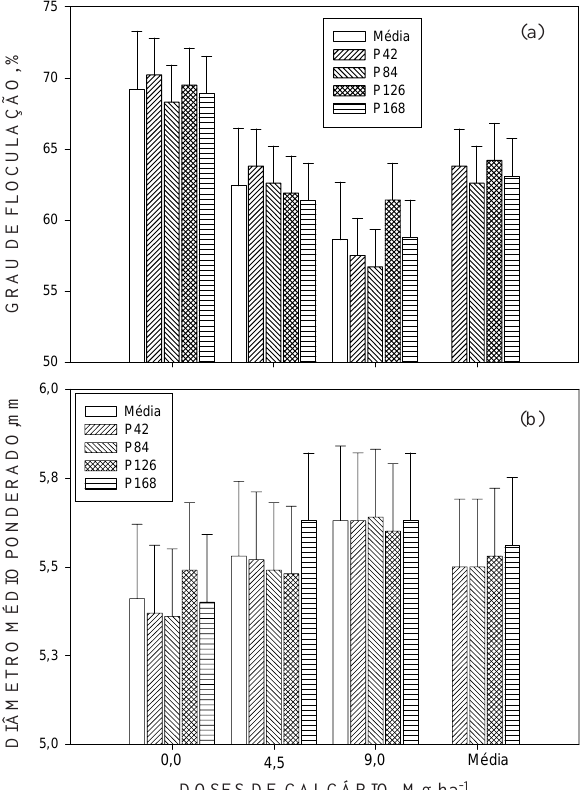
Figura 1. Efeito da calagem e adubação fosfatada sobre o grau de floculação da argila (a) e sobre o diâmetro médio ponderado dos agregados (b) de um Latossolo Bruno argiloso álico. Barras verticais entre médias do fator fósforo e entre médias do fator calcário correspondem às diferenças mínimas significativas calculadas pelo teste de Tukey, a 5